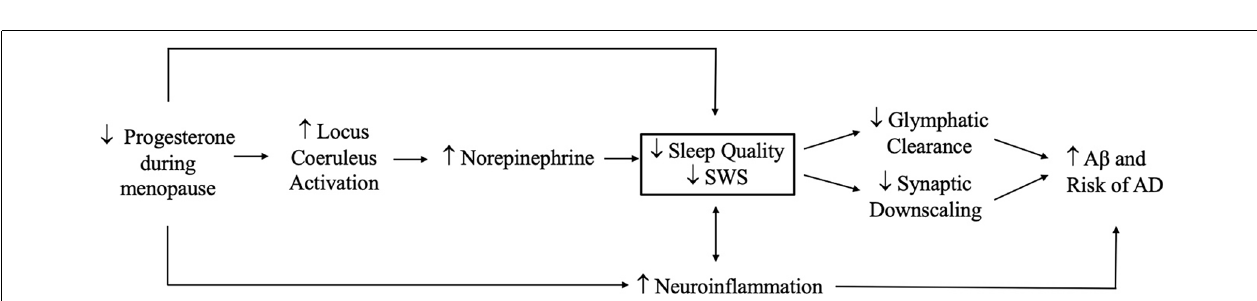
FIGURE 5 | Effects of progesterone reduction during menopause on sleep and Alzheimer’s disease (AD) risk. Reductions in progesterone during menopause may increase activation of the locus coeruleus and subsequent norepinephrine production, leading to decreases in slow wave sleep (SWS) and reductions in glymphatic clearance and synaptic downscaling that promote amyloid beta (A β ) aggregation and AD risk. Additionally, reductions in progesterone could increase neuroinflammation, which promotes sleep disturbances and lowers SWS, leading to further neuroinflammation and a bidirectional link with sleep. Note: not all plausible pathways are